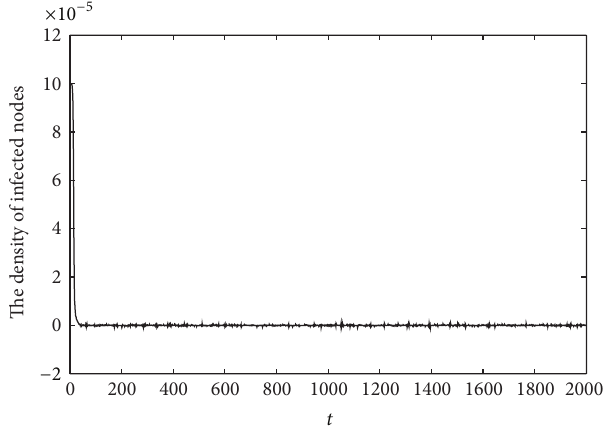
Figure 4: The density of infected nodes with parameters 𝜇 = 0.01 , = 0.01 , 𝑟 = 0.06 , 𝑟 = 0.06 , 𝛼 = 1.5 × 10 −8 < 𝛼 𝑟 𝑠 1 2 𝑁 = 100000 .